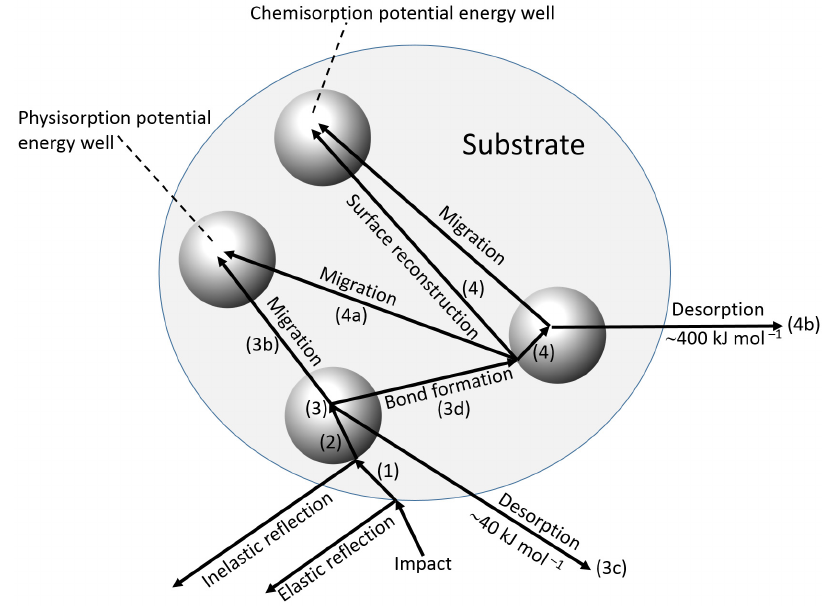
Figure 8. The sequence of events at a surface leading to